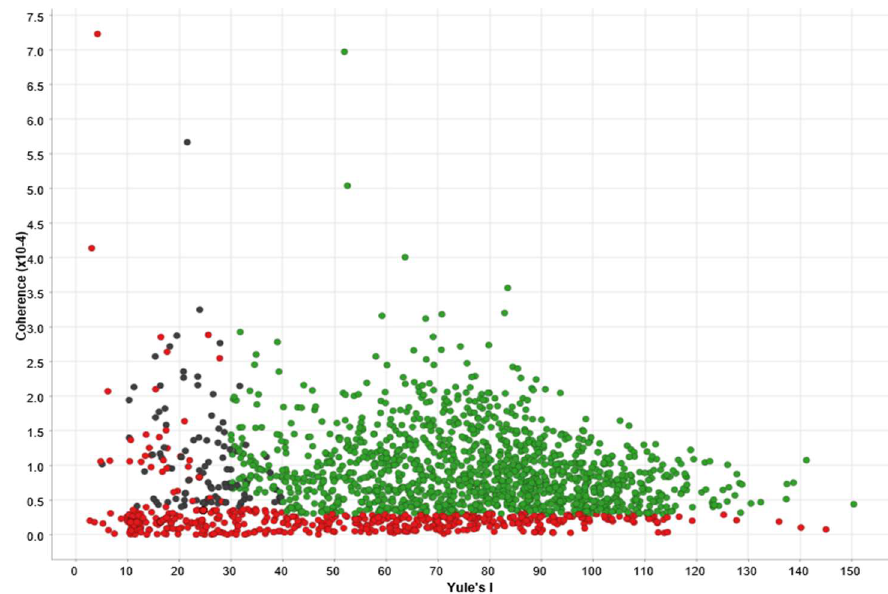
Figure 2. Quality metrics for the top-2000 users according to published tweets in the stream. Green points are good users, black points are users that need manual inspection, and red points are users that should be filtered out.